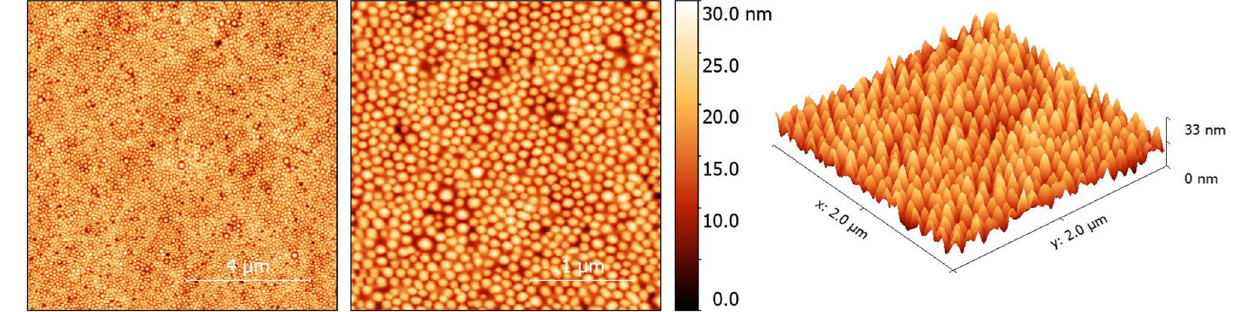
Figure 4. Atomic force microscopy images of BSA-DF-C12 lyophilized sample spin-coated and measured in